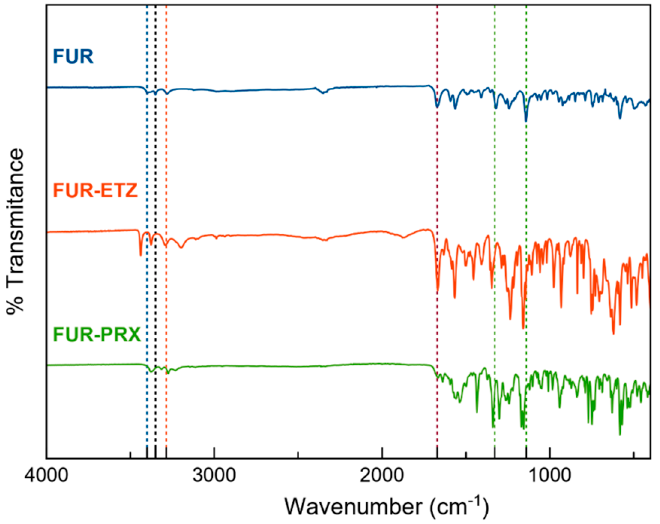
Figure 5. Comparison of Fourier transform infrared (FT − IR) spectra of FUR, FUR–ETZ and FUR–PRX solid forms.